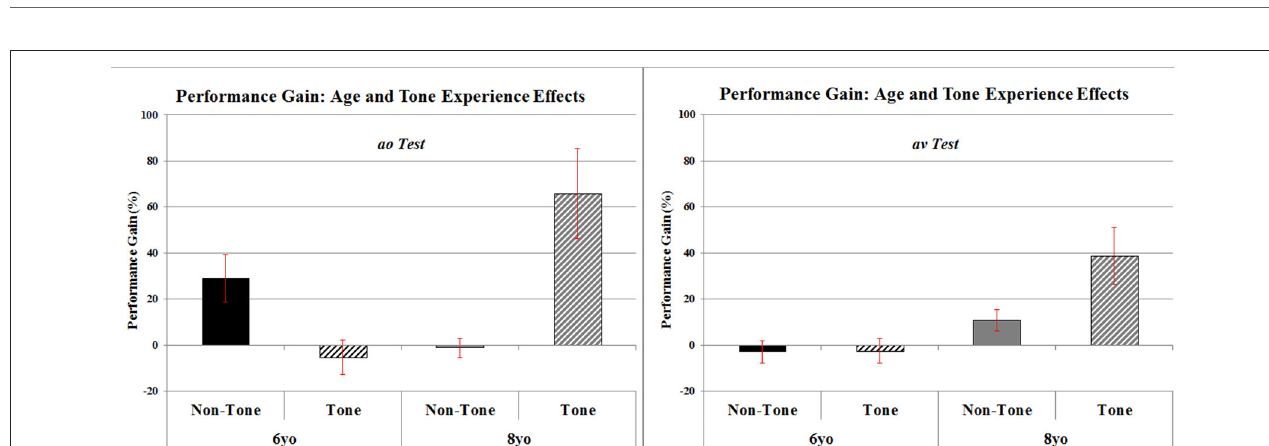
FIGURE 4 | Mean percentage of Pre- to Post-training performance gain for Mandarin Tone Perception including effects of Age (6yo vs. 8yo), Tone Experience (Non-Tone vs. Tone), and Test Types (ao vs. av). Error bars represent standard errors.